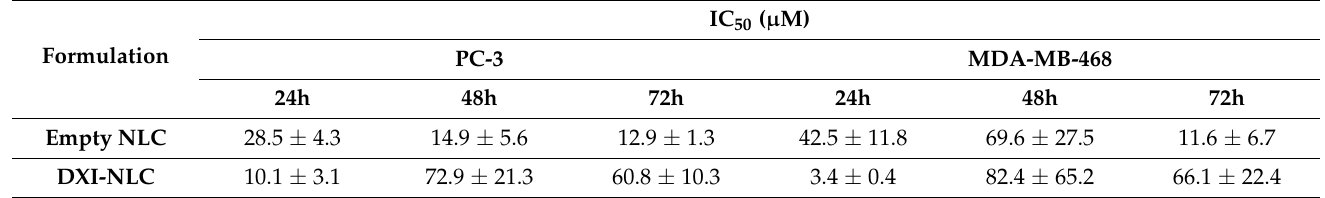
Table 7. IC 50 values of DXI-NLC and empty NLC at several incubation times.